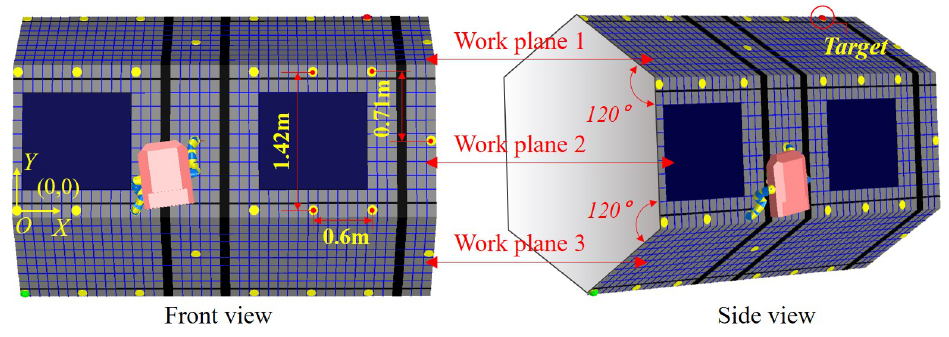
Figure 5. Simulation environment setup based on the